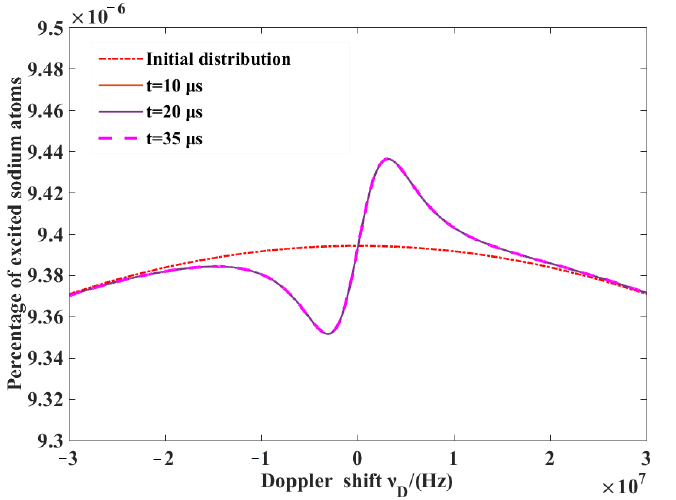
Figure 3. Normalized distributions of sodium atoms with linewidth broadening at t = 10 µ s, 20 µ s, and 35 µ s.